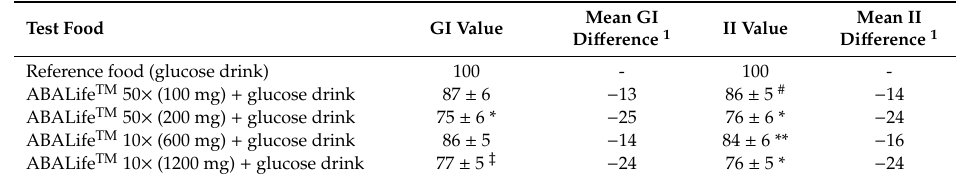
Table 1. Glycemic index (GI) and insulinemic index (II) values for the four test beverages containing ABALife ™ fig fruit extracts relative to the reference glucose solution (GI and II = 100). Data are mean ± SEM, n = 10. The two lower doses of each fig fruit extract (FFE), 100 mg FFE-50 × and 600 mg FFE-50 × , contained 40 µ g abscisic acid, and the two higher doses of each FFE, 200 mg FFE-50 × and 1200 mg FFE-10 × , contained 80 µ g abscisic acid.